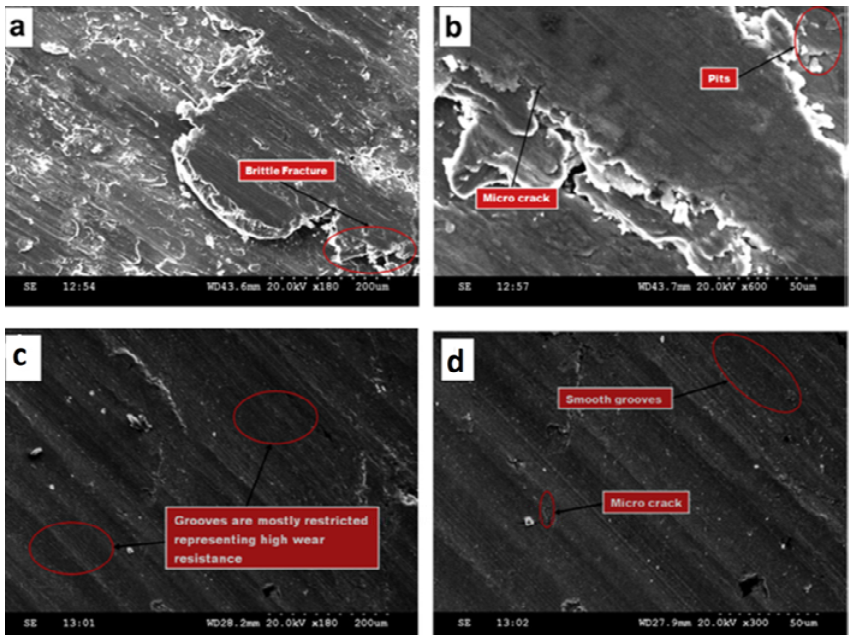
Fig. 5. SEM morphologies of the worn surface of nano-Al 2024 matrix (a) at low-magnification, (b) at high- magnification and Al/5%SiC/10%Gr hybrid nano-composite (c) at low-magnification, (d) at high-magnifica- tion on applied load of 20N, adapted from [35].